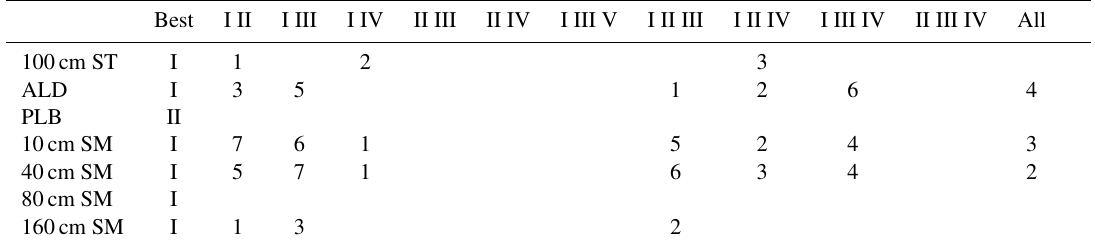
Best column shows the model simulations (individual parameter substitution) with the smallest root mean square error (RMSE) for 100cm soil temperature (ST, ◦ C); active layer depth (ALD, m); permafrost low boundary (PLB, m); 10, 40, 80, and 160cm soil liquid water content (SM, -). Numbers indicate the combination of parameters that have smaller RMSE than the best model run using individual parameter substitution. The column All indicates the combination of all four parameters. The smallest number indicates the smallest